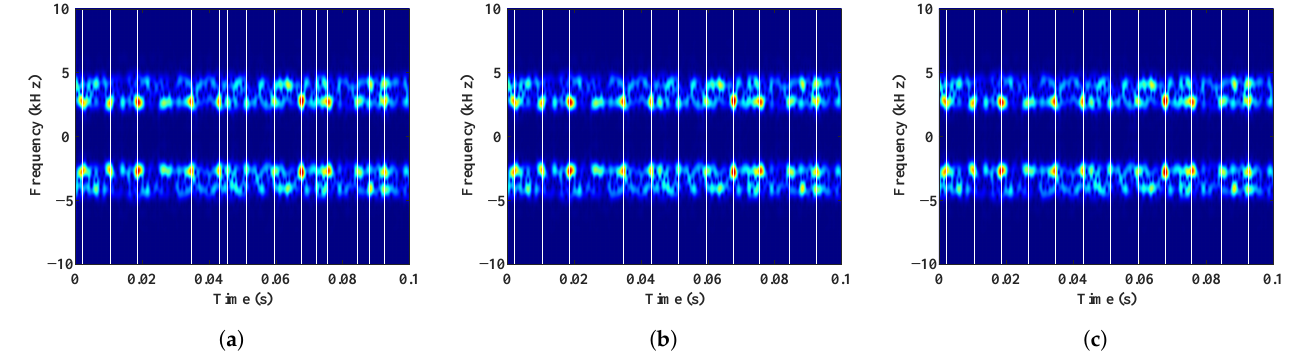
Figure 12. High-frequency flicker correction schematic diagram. ( a ) Before correction. ( b ) First correction. ( c ) Complete